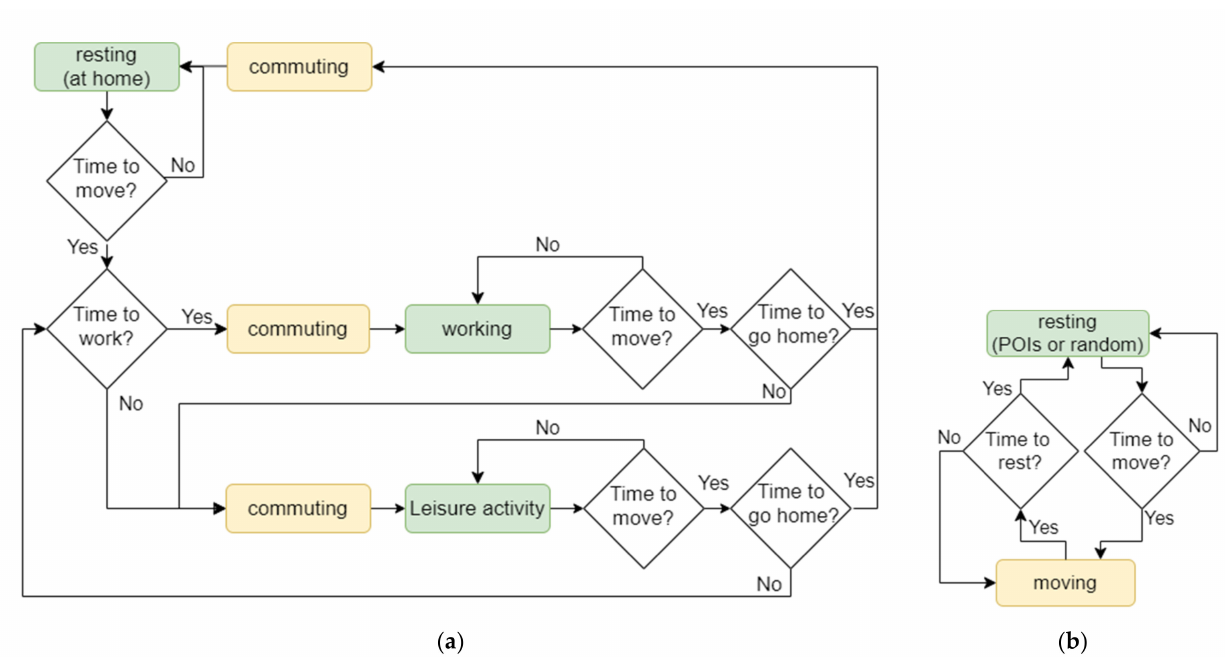
Figure 2. Behaviour and states of: ( a ) the people agents and ( b ) the missing